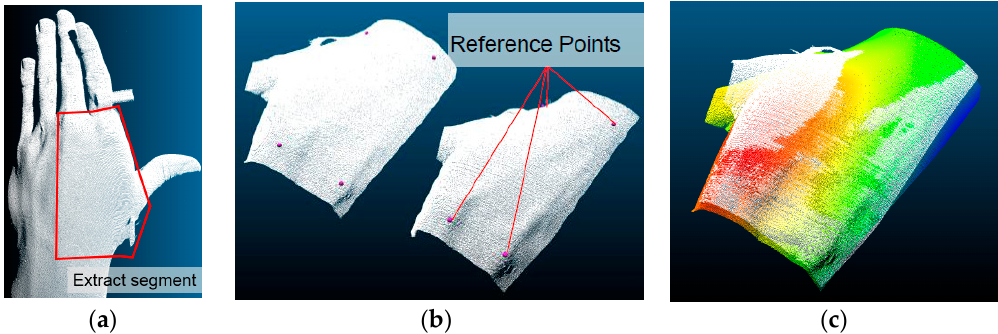
Figure 4. 3D hand surface data conditioning (Subject 3): ( a ) cropping out unused data points; ( b ) align (point pairs picking) process; ( c ) alignment image after fine alignment process.